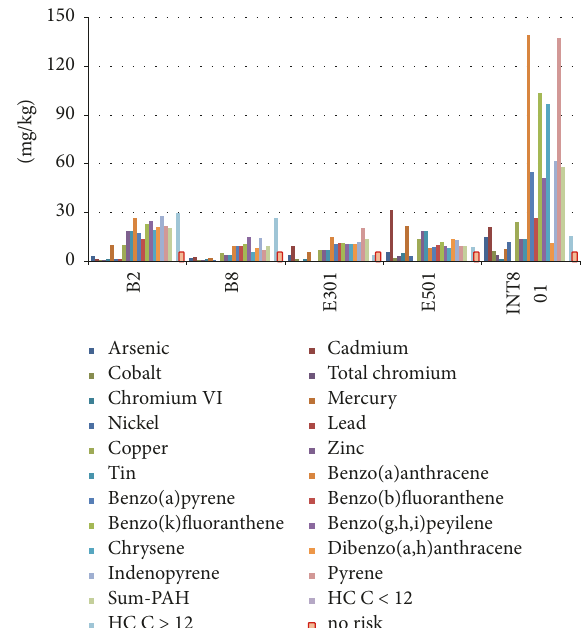
Figure 9: MAD test for sampling points at highest environmental risk (all sampling